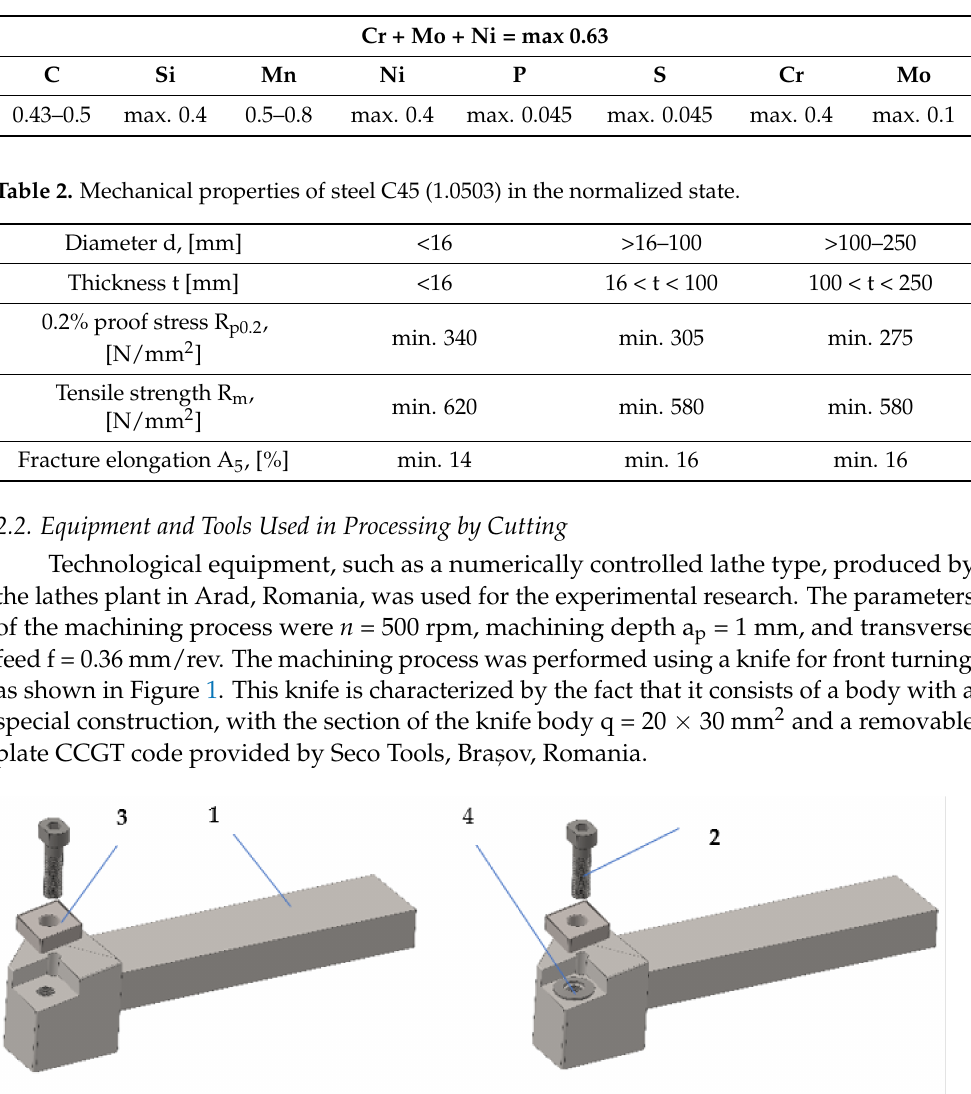
Table 1. Chemical composition of steel C45 (1.0503), %.